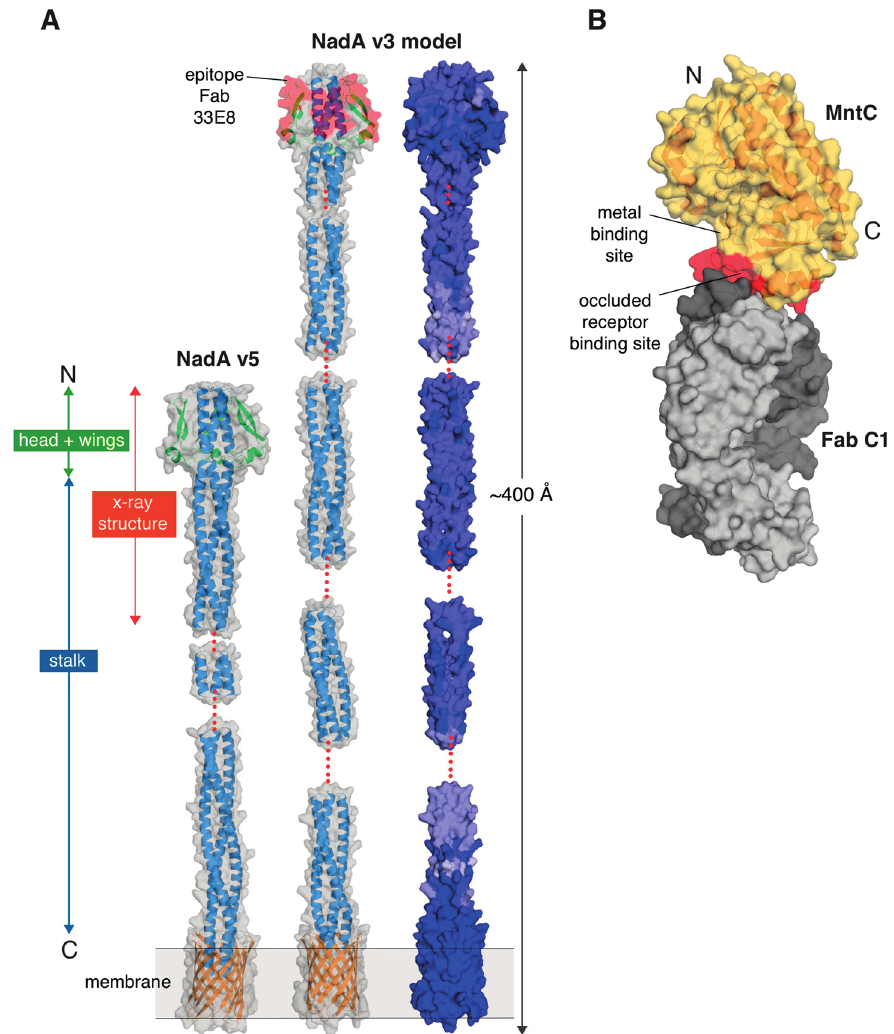
Figure 1. ( A ) The structure of the meningococcal antigen Neisseria adhesin A (NadA) variant 5 (pdb 4CJD) is shown on the left, with the region experimentally determined by X-ray crystallography labeled in red. The two main domains of NadA (head + wings and stalk) are labeled with green and blue arrows/boxes, respectively. All other regions were defined by homology modelling, as described previously [20]. A homology model of NadA variant 3 is also shown, with sequence conservation among variants 1–5 depicted as a gradient from light blue (low sequence identity) to dark blue (high sequence identity). The modeled transmembrane anchor is shown in orange. Red dots indicate regions that were not modeled due to lack of predicted coiled-coil periodicity or homology; ( B ) A surface representation of the co-crystal structure of the staphylococcal antigen MntC (semi-transparent light yellow surface and dark yellow cartoon) bound to Fab C1 (light and dark grey surfaces depicting light and heavy chains, respectively) (pdb 4NNP). The binding site of C1 on the surface of MntC (red patch) provides insights into the mechanisms of interaction between MntC and its natural receptor MntB. The Mn 2+ -binding site and the occluded MntB receptor binding sites on MntC are labelled. All figures